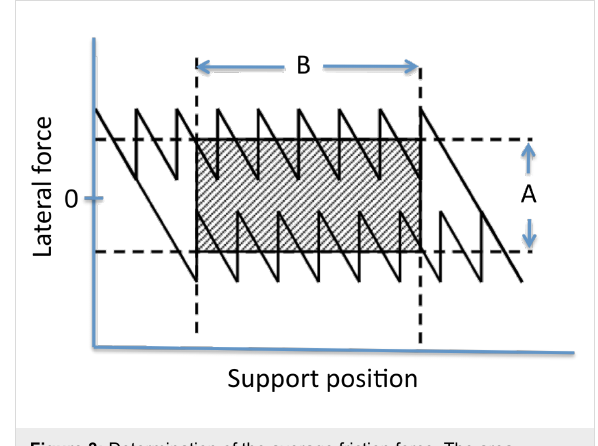
Figure 3: Determination of the average friction force. The area enclosed by the dashed lines provides the best estimate of the typical energy dissipated during sliding. The average friction force is obtained by dividing the energy contained in the shaded area by 2•B.